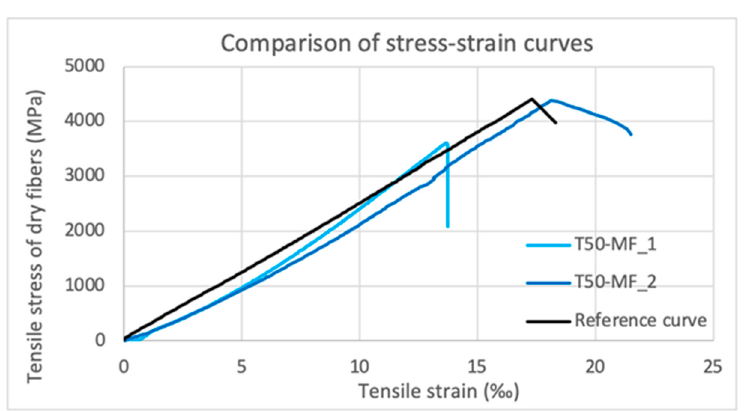
Figure 15. Stress–strain curves of monotonic, uniaxial tensile tests at 50 °C (T50-MF_1) and at room temperature (T50-MF_2) after exposure to 50 °C.